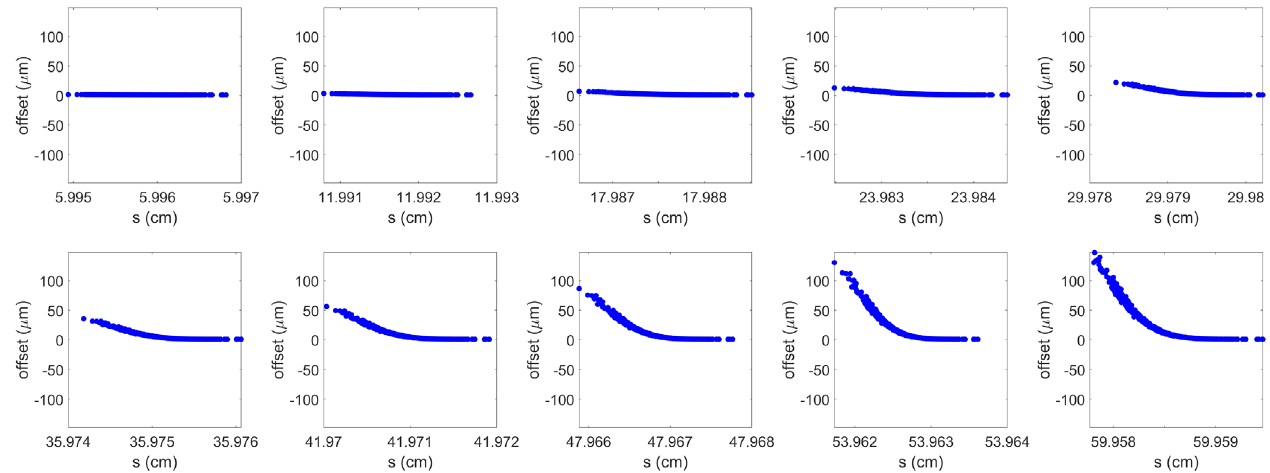
FIG. 13. Snapshot of beam movement, which offsets 1 μ m, inside a DLW ( a ¼ 148 μ m and b ¼ 178 μ m) at different location s